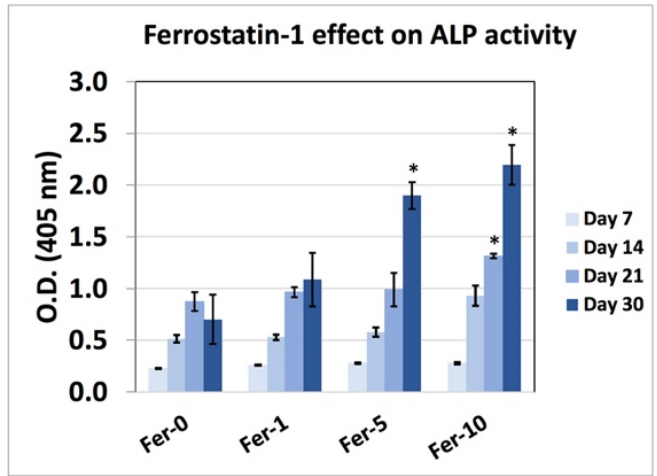
Figure 7. ALP activity for MC3T3-E1 cells upon exposure to Fer-0, Fer-01, Fer-05, and Fer-10 after 7, 14, 21, and 30 days of incubation. (* p < 0.01).